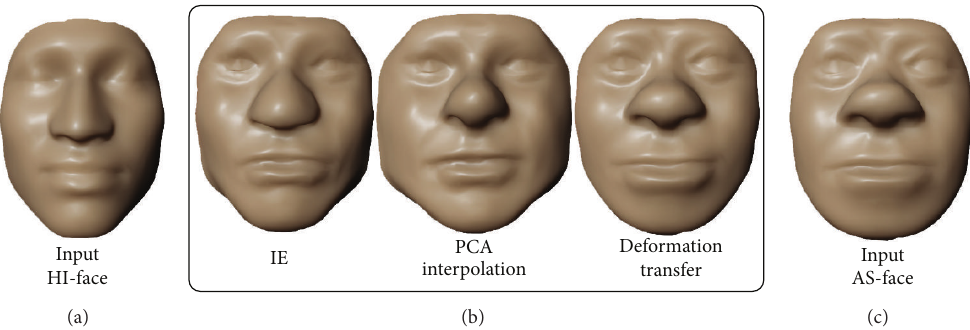
Figure 4: Comparison of different blending schemes. (a) Shape transferring using deformation transfer algorithm [24], (b) 50/50 linear interpolation between their corresponding PCA feature vectors, and (c) the result by our identity engineering (IE)